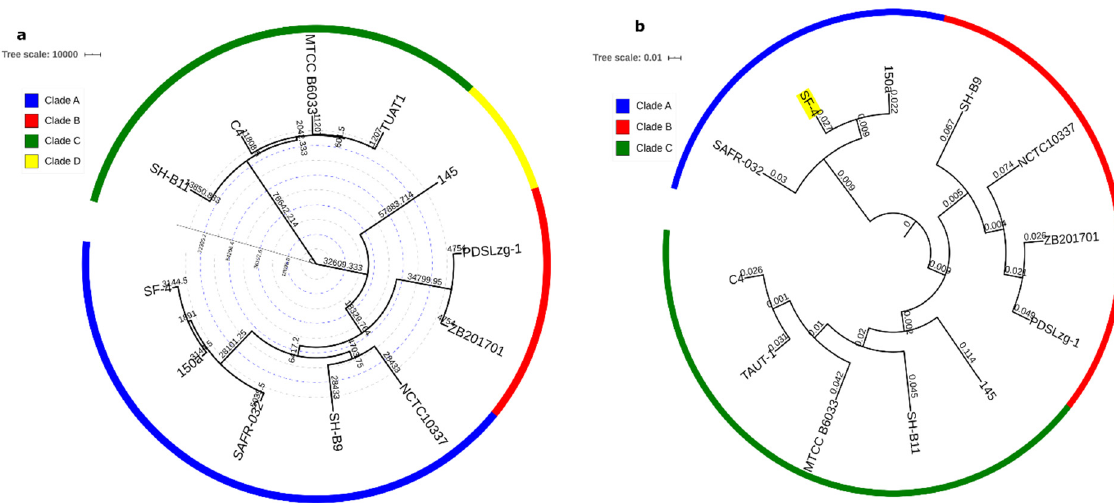
Figure 3. ( a ) Phylogenetic tree based on whole-genome SNP of B. pumilus strains, rooted with Bacillus cereus (accession number AE016877) as an outgroup which was removed from the final figure. The length of the scale bar indicates nucleotide substitution 10,000 sites. Branch length is proportional to the numbers of SNPs that are given above each branch ( b ). The core phylogeny tree was constructed based on 2962 concatenated core proteins of 12 B. pumilus genomes. The number alongside each branch represents the time of divergence (Million years ago). The trees were generated by the maximum likelihood (ML) method, in MEGAX and were edited in iTOL (https://itol.embl.de/, accessed on 28 February 2021).